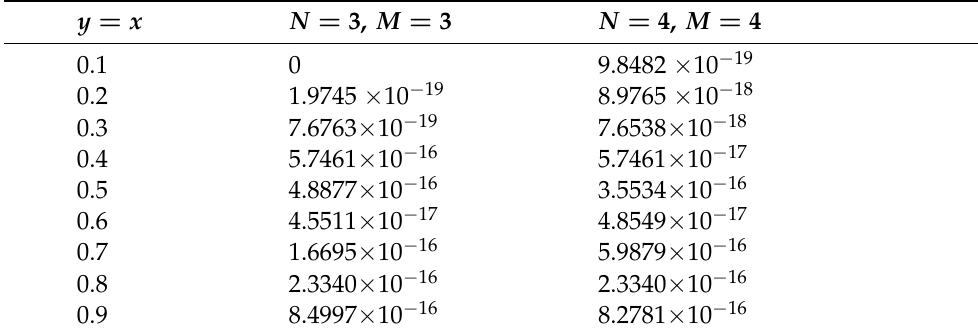
Table 3. The maximum norm errors of Example